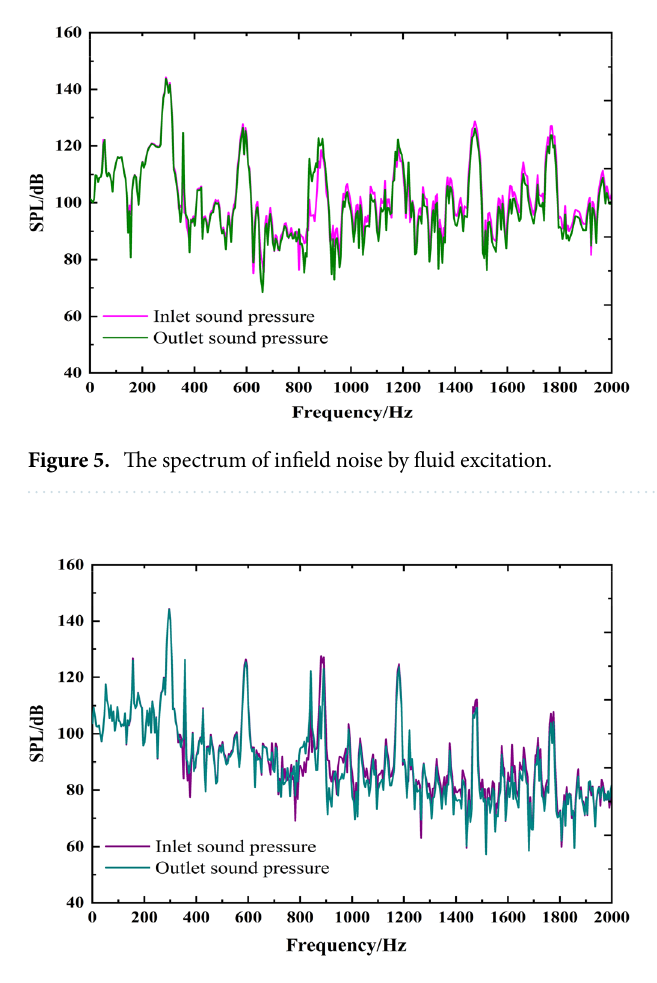
Figure 6. The spectrum of infield noise by surface